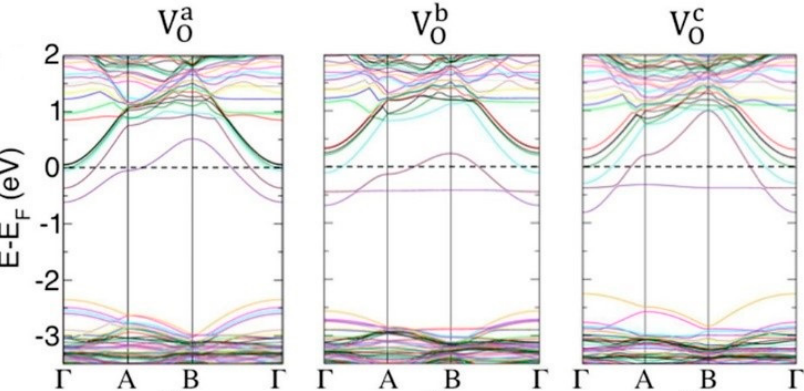
Figure 6. Electronic structure of defective WO 3 surfaces with oxygen vacancies formed along the indicated axes. The Fermi level is represented by a horizontal dashed line at E-E F = 0. Reprinted with permission from Figure 3a in ref. [130] : E. Albanese, C. Di Valentin, Gianfranco Pacchioni, “H 2 O Adsorption on WO 3 and WO 3 − x (001) Surfaces”, ACS Appl. Mater. Interfaces 2017, 9, (27),